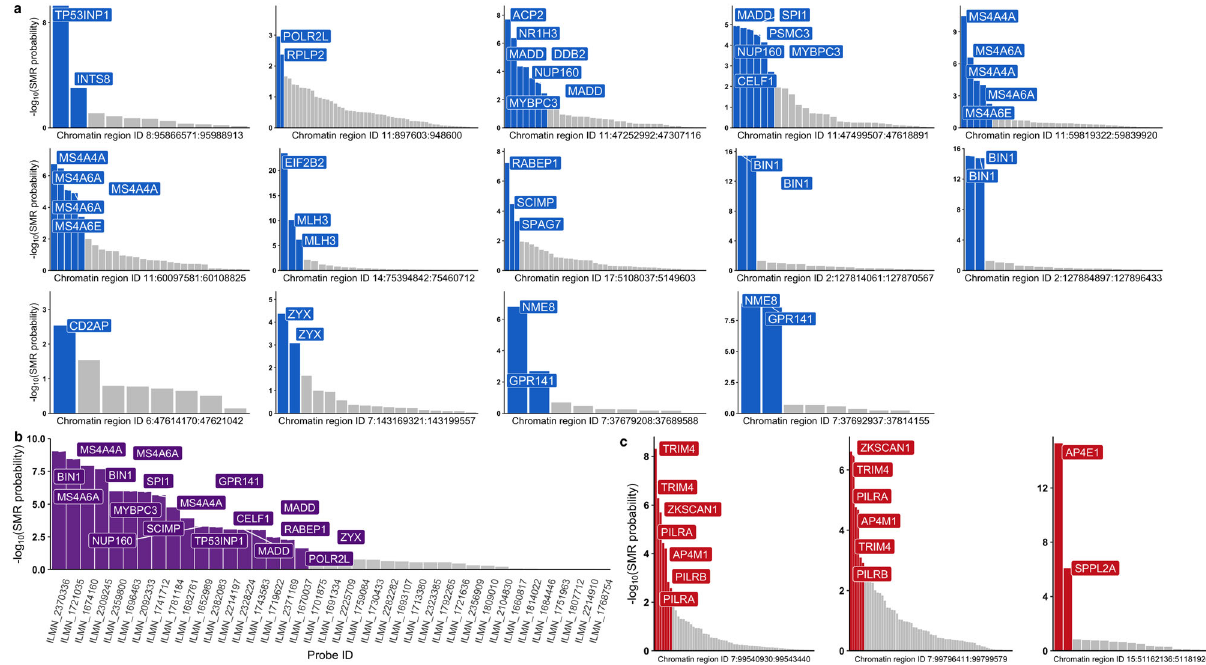
Fig. 3 Putative causal associations between chromatin activity, target gene expression regulation and AD risk modi fi cation point to candidate causal genes in myeloid cells. a -Log10 of causal association probabilities between chromatin activity and gene expression in monocytes obtained through SMR analysis for each probe are plotted for each chromatin region. Probes (labeled by the respective gene) in blue indicate signi fi cant associations, while grey bars indicate non-signi fi cant associations based on a 5% FDR threshold. b -Log10 of causal association probabilities between gene expression and AD risk. Probes (labeled by their respective gene) in purple indicate signi fi cant associations, while grey bars indicate non-signi fi cant associations based on a 5% FDR threshold. c -Log10 of causal association probabilities between activity of two active chromatin regions in the PILRA locus and one active chromatin region in the SPPL2A locus and gene expression in monocytes obtained through SMR analysis for each probe are plotted. Probes (labeled by the respective gene) in red indicate signi fi cant associations, while grey bars indicate non-signi fi cant associations based on a 5% FDR threshold. Table 2 Candidate causal genes identi fi ed through integration of AD GWAS signals with myeloid active enhancer annotations, hQTL, and eQTL